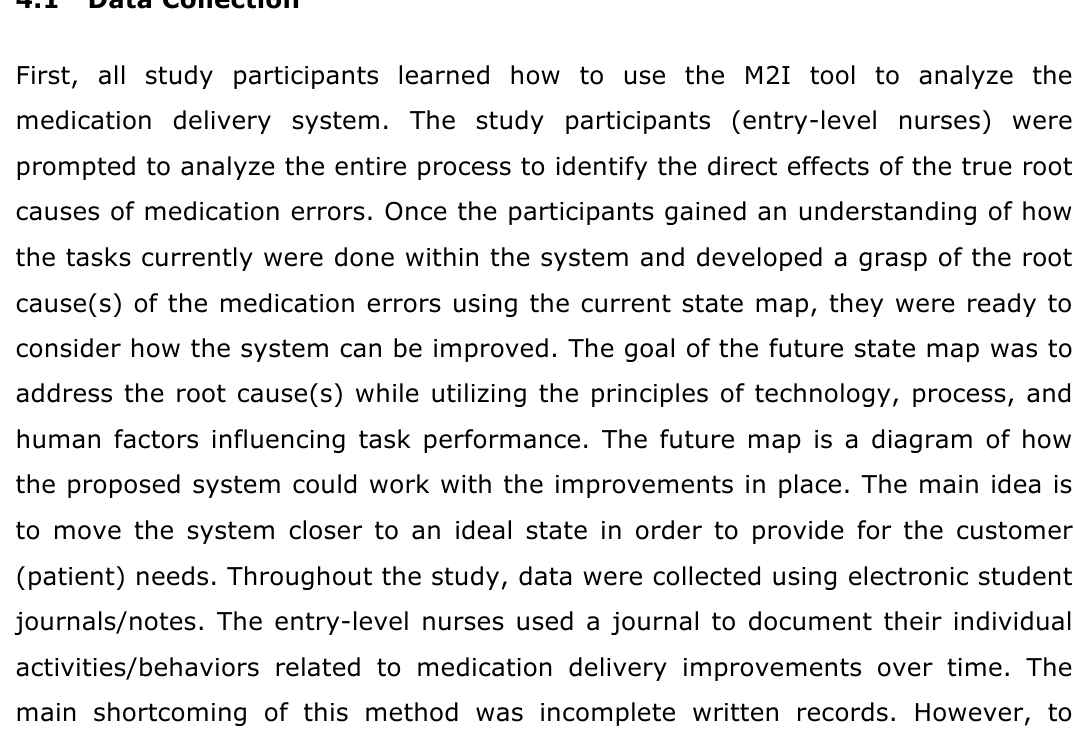
Figure 2. The survey instrument contained one positively and one reversed negatively worded close-ended questions for every predictor variable under